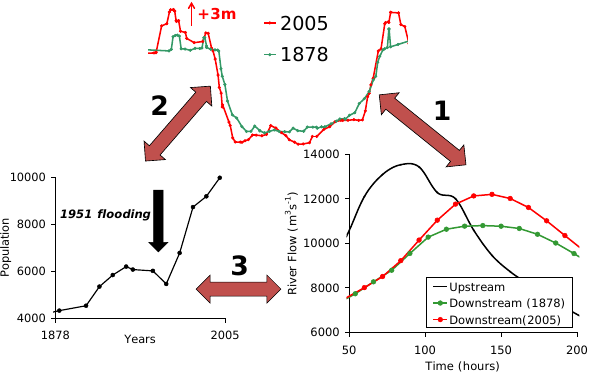
Figure 4. Analysing the socio-hydrology of floodplain systems: Changes in the cross section 3 Fig. 4. Analysing the socio-hydrology of floodplain systems: of Po River at Pontelagoscuro (Italy) in the period 1878-2005, showing the significant levee 4 changes in the cross section of Po River at Pontelagoscuro (Italy) in the period 1878–2005, showing the significant levee heighten- heightening of around 3m [top panel]; Hydrological changes in flood magnitude due to levee 5 ing of around 3m (top panel); hydrological changes in flood mag- heightening [bottom-right]; Human population dynamics in the floodplain areas "protected" 6 nitude due to levee heightening (bottom right); human population by the (continuously heightened) levees [bottom-left panel]. 7 dynamics in the floodplain areas “protected” by the (continuously heightened) levees (bottom left